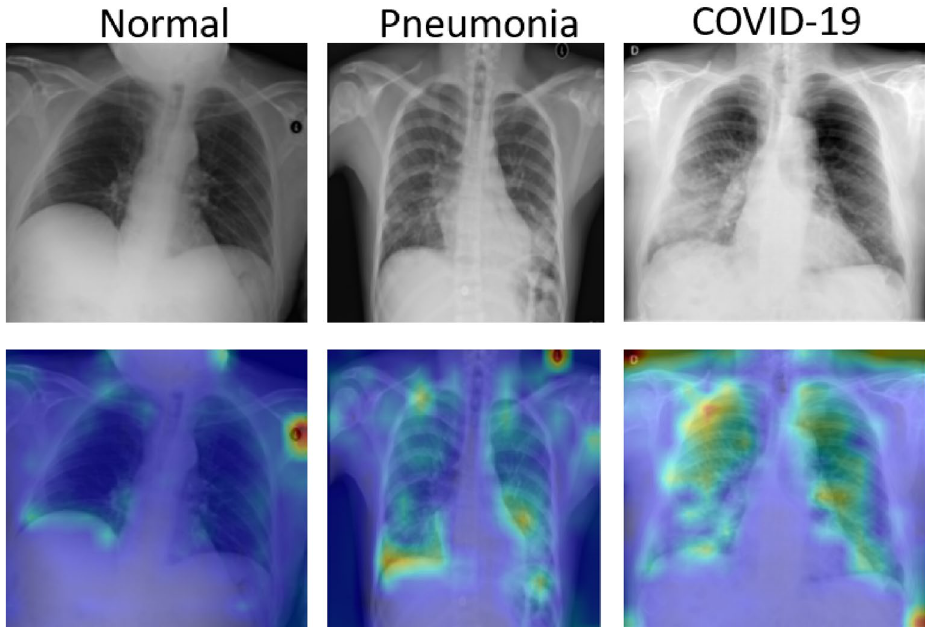
Figure 7. The first row: original images; second row: attention map obtained by our proposed DAM-Net.